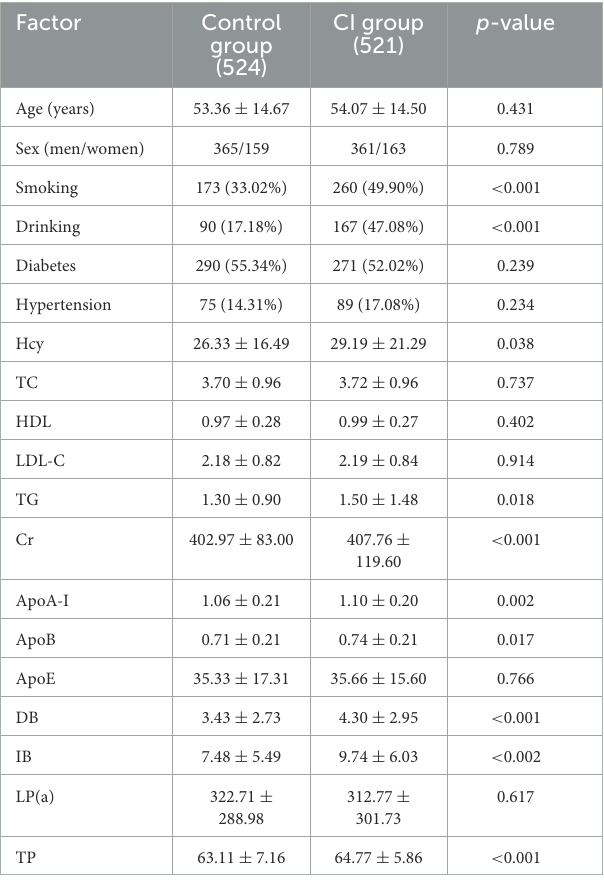
TABLE 1 Characteristics of the study